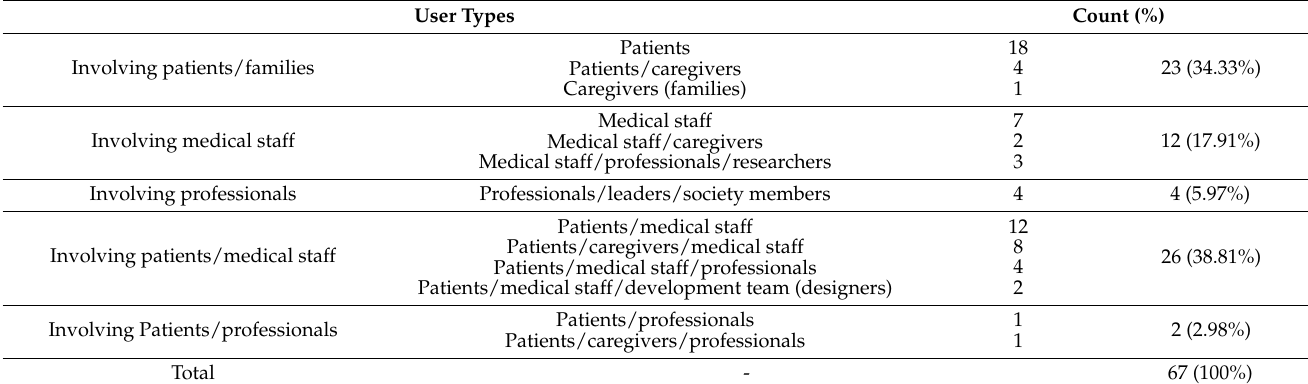
Table 5. Summary of user